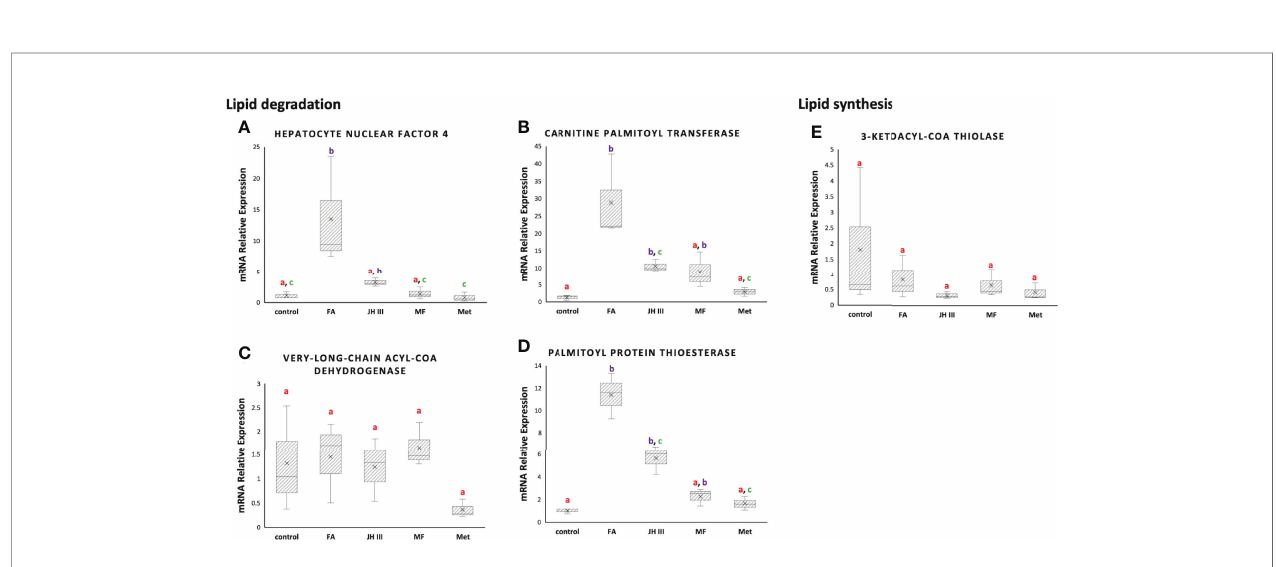
FIGURE 5 | Expression of lipid metabolism genes, including the lipid degrading (A) hepatocyte nuclear factor 4 ( hnf4 ), (B) carnitine palmitoyl transferase ( cpt ), (C) very-long-chain acyl-CoA dehydrogenase ( vlcad ) and (D) palmitoyl protein thioesterase ( ppt ), and the lipid synthesizing (E) 3-ketoacyl-CoA thiolase ( kat ) mRNA expression in hepatopancreas of S. paramamosain under FA, JH III, MF and Met treatments compared with control. Expression levels were calibrated for each gene using 18S rRNA as the housekeeping gene ( D Ct=Ct gene -Ct 18S rRNA ) and normalized using the pool of control group ( DD Ct= D Ct - mean D Ct control ). mRNA relative expression=fold change=2 - DD Ct . Different letters above boxes and whiskers denote signi fi cant difference between treatments at P ≤ 0.05 (n = 3).